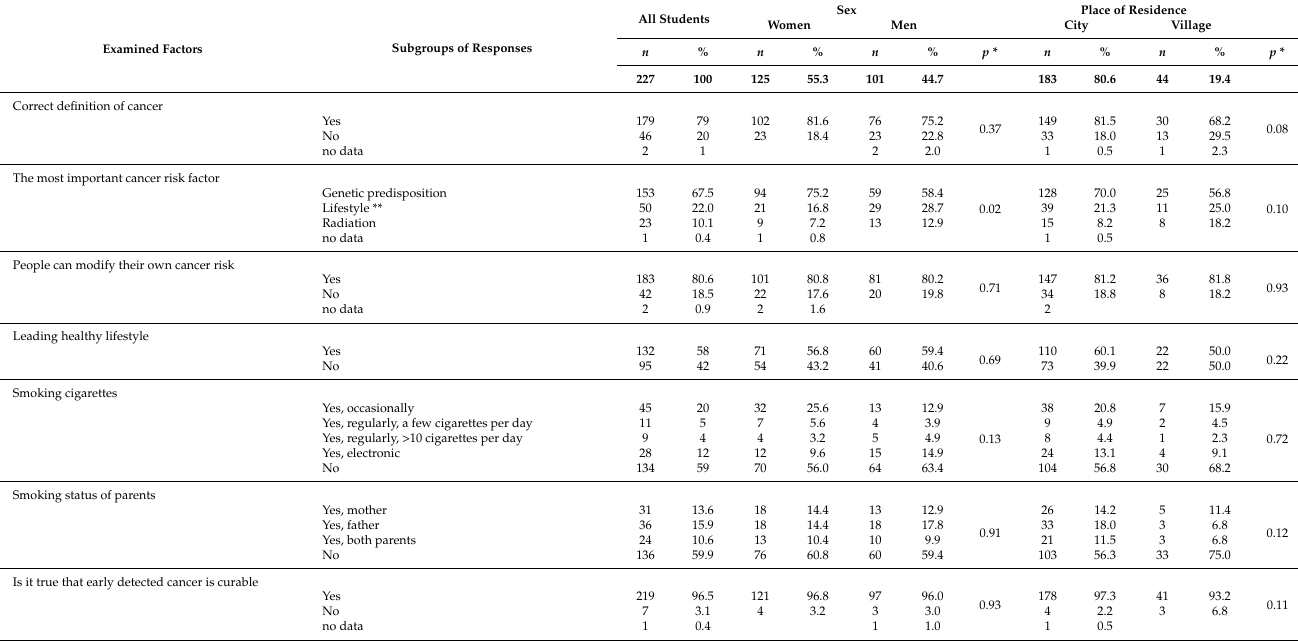
with sex or place of residence. However, students living in cities more frequently indicated the right definition of cancer ( p = 0.08; X 2 test) (Table 2). Table 2. The differences in student’s knowledge about cancer due to demographic